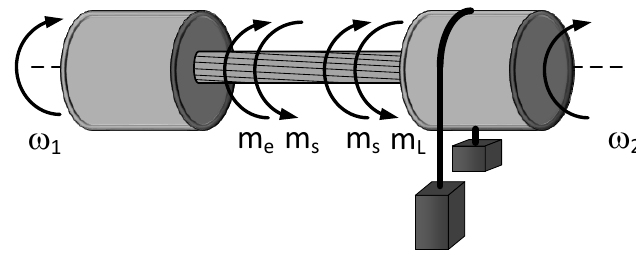
Figure 1. Block diagram of the mechanical two-mass drive system.